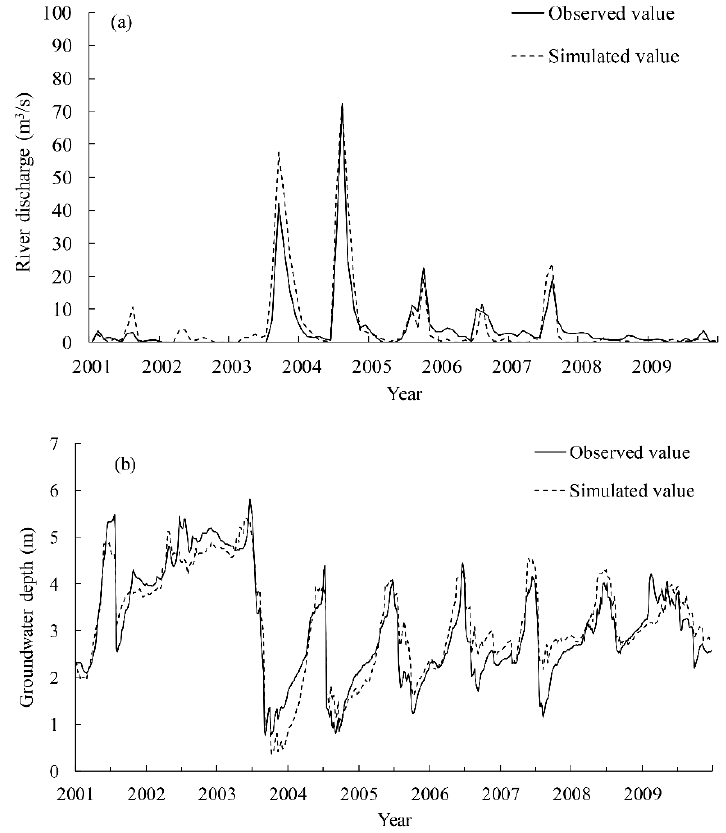
Figure 5. Comparison of the observed and simulated processes of ( a ) the river discharge and ( b ) the groundwater depth under maximizing the multi-objective function NSE union .